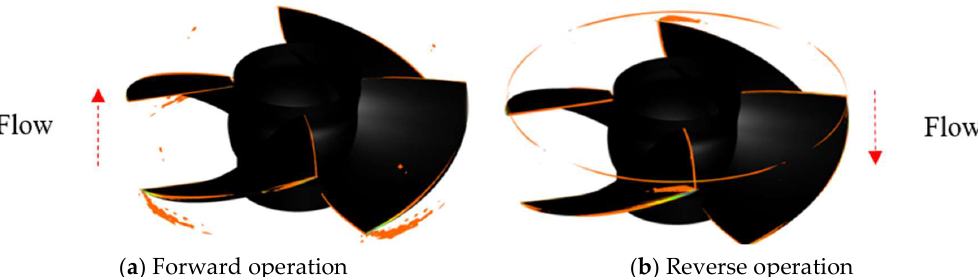
Figure 21. 1.1 Q d impeller internal vorticity distribution diagram.